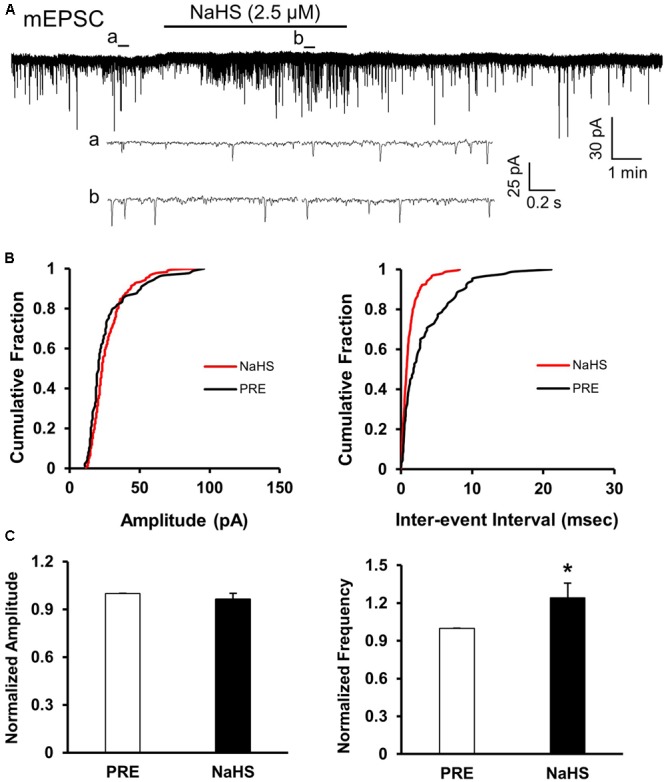
NaHS enhanced the frequency of mEPSCs in control group. (A) Representative current traces of mEPSCs recorded in the presence and absence of NaHS (2.5 μM). Na+ channel blocker TTX (1 μM) was used in Kreb solution. a: An expanded trace for mEPSC recorded in the absence of NaHS; b: an expanded trace for mEPSC recorded in the presence of NaHS. (B) Cumulative distribution analysis of peak amplitude and inter-event intervals from the same neuron showed that NaHS reduced the inter-event intervals of mEPSC (n = 10, P < 0.01, Kolmogorov–Smirnov test) but had no effect on the amplitude. (C) Bar plot showing NaHS significantly increased mean frequency of sEPSCs but not amplitude. n = 10, ∗P < 0.05.